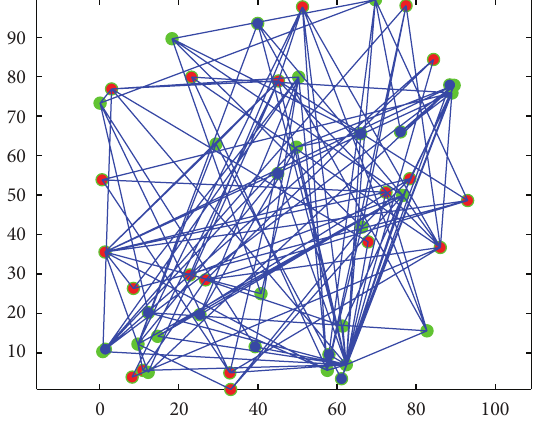
Figure 6: Topology structure of cluster supply chain network.